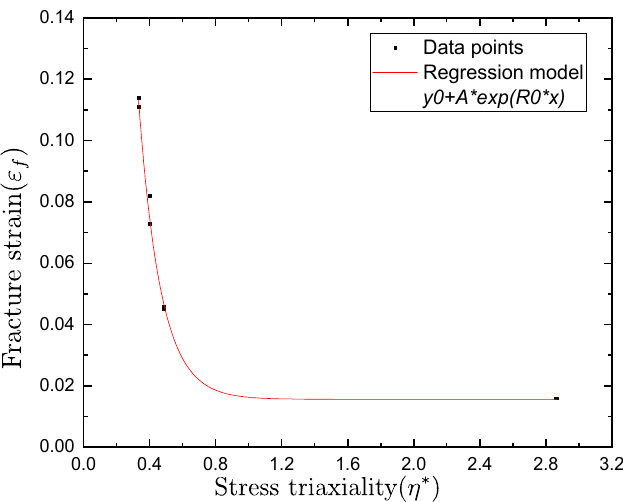
Figure A1. Fracture strain and stress triaxiality relationship from uniaxial tensile test data based on fracture point calculation.